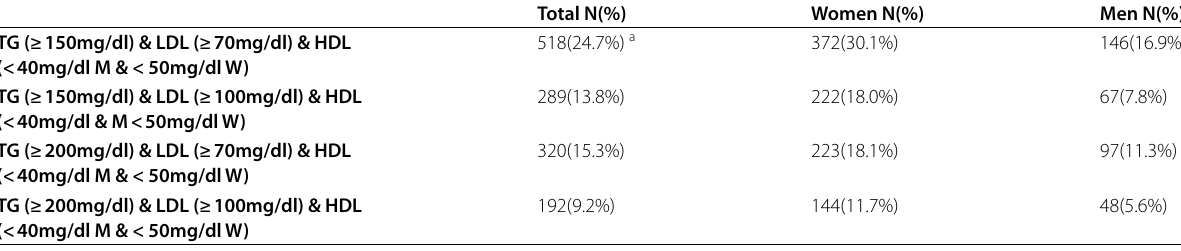
Table 3 Patterns of triple combination dyslipidemia in the studied population